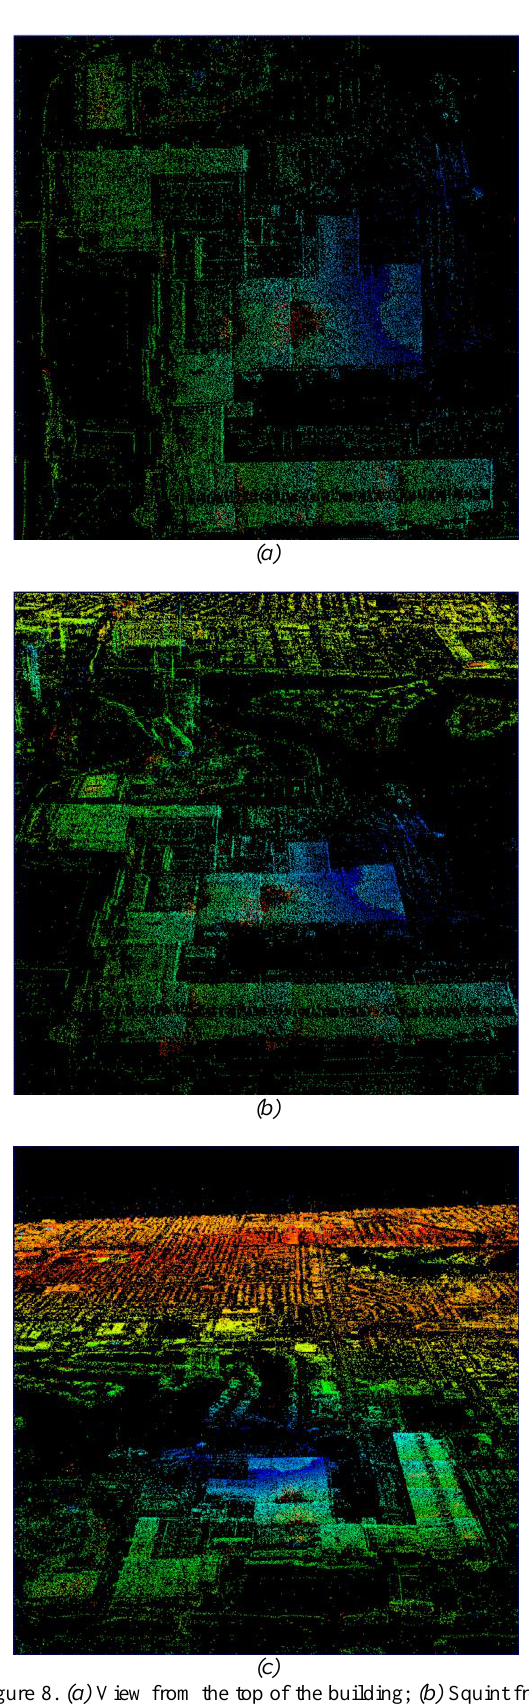
Figure 8. (a) View from the top of the building; (b) Squint from the front of the building; (c) View from the side of the building.